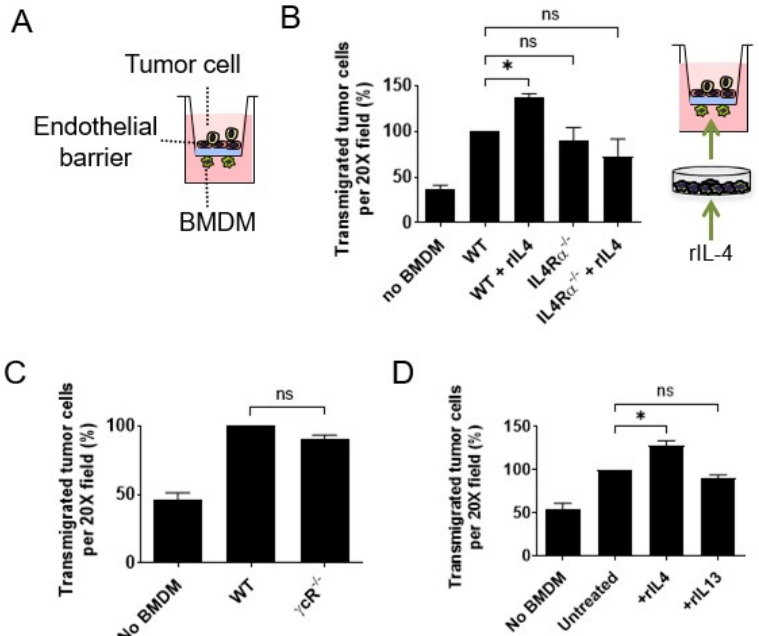
Figure 1. IL4 promotes macrophage-mediated tumor cell transendothelial migration. ( A ) Schematics of the transendothelial migration assay modeling extravasation (eTEM). An endothelial monolayer (red) sits over a Matrigel-coated transwell. Endothelial barrier is exposed to tumor cells on the apical domain. Macrophages are added to the bottom side of the transwell insert (closer to the basal domain of the endothelial barrier). Tumor cells that migrate through the endothelial layer and matrigel are quantified once present in the bottom side of the transwell insert. ( B ) Transendothelial migration of E0771-LG cells in response to WT or IL4rα-null BMDMs pre-incubated with vehicle or rIL4. ANOVA and Dunnett correction, n = 3, * p -value < 0.05. ( C ) Transendothelial migration of Met-1 cells in presence of BMDM deficient for the IL4R co-receptor γ C R. Mann–Whitney test, n = 3, p -value > 0.1. ( D ) Transendothelial migration of Met-1 cells in response to WT BMDMs pre-incubated with recombinant IL4 or IL13 for 24 h. Mann–Whitney test, n = 3, * p -value < 0.01. Data are presented as the mean normalized to WT or untreated control +/ − SD. Each experiment was performed in duplicate or triplicate, and each n corresponds to an independent experiment performed with BMDM from independent